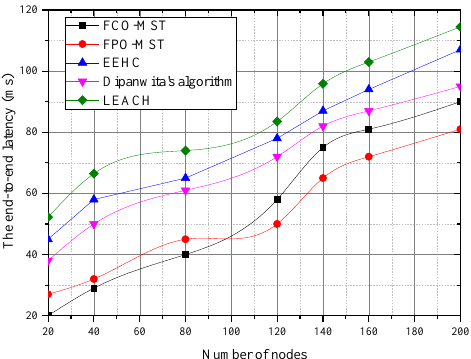
Figure 11. The comparison of E2EL under a different number of nodes.